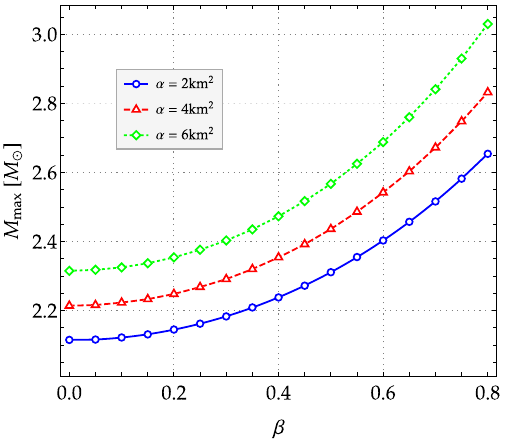
Fig. 5 Maximum mass as a function of the charge parameter β for three values of the GB coupling constant, where a quadratic behavior can be observed